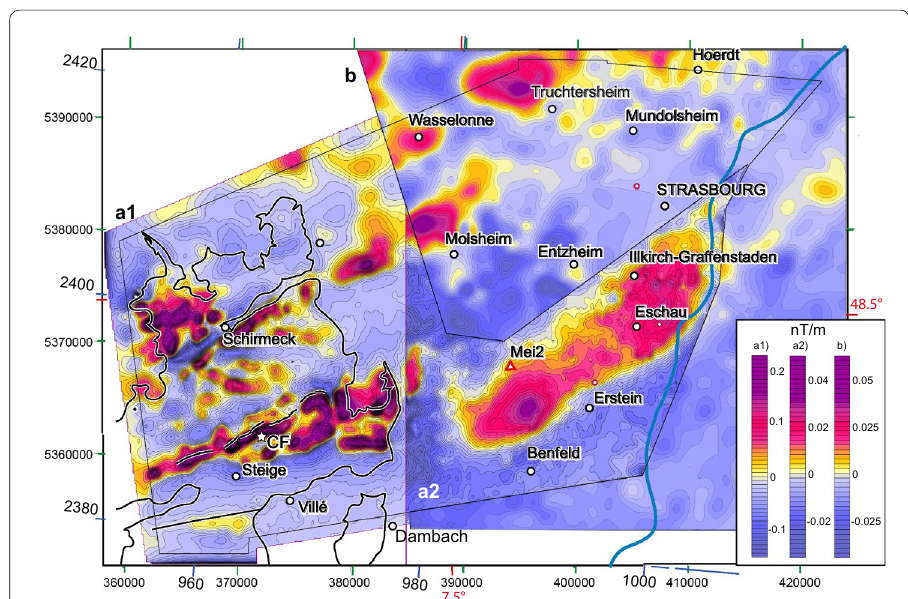
Fig. 6 a Aeromagnetic map of the geothermal project (2015): vertical derivative of the upward continuation by 100 m, reduced to the pole. The magnetic sources of the basement being about 1.7 km deeper in the graben (1b), the scale of the anomaly intensities (in nT/m) has been expanded. b Magnetic map at the ground level (Edel et al. 1982): vertical derivative of the upward continuation by 400 m, reduced to the pole. Coordinates: Lat/Long in red, Lambert II extended in blue, UTM zone 32 N in